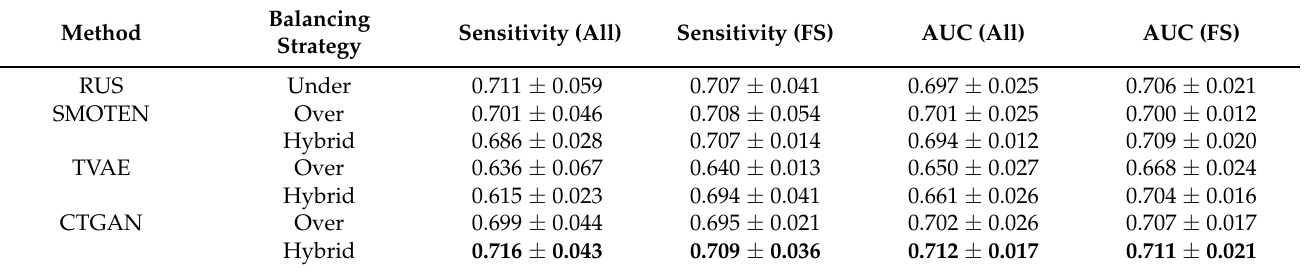
Table 3. Sensitivity and AUC values (mean ± std) on 5 test subsets when training ML models using different resampling strategies with all features and FS. The highest average performance for each figure of merit is marked in